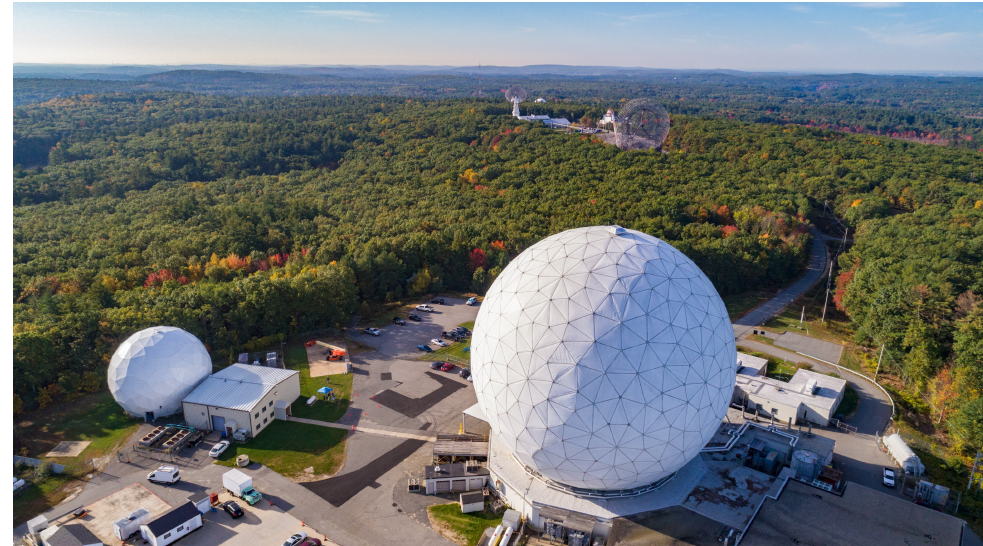
Figure 1. Aerial view of MIT Haystack Observatory. The Haystack Telescope, a dish of 37 m diameter, is located in the large radome dominating the foreground. (Used with permission, courtesy of Mark Derome).